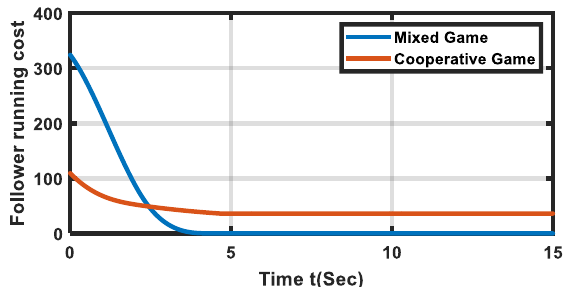
Figure 10. Follower running cost for developed mixed game theory-based distributed approach and the traditional cooperative game-based centralized